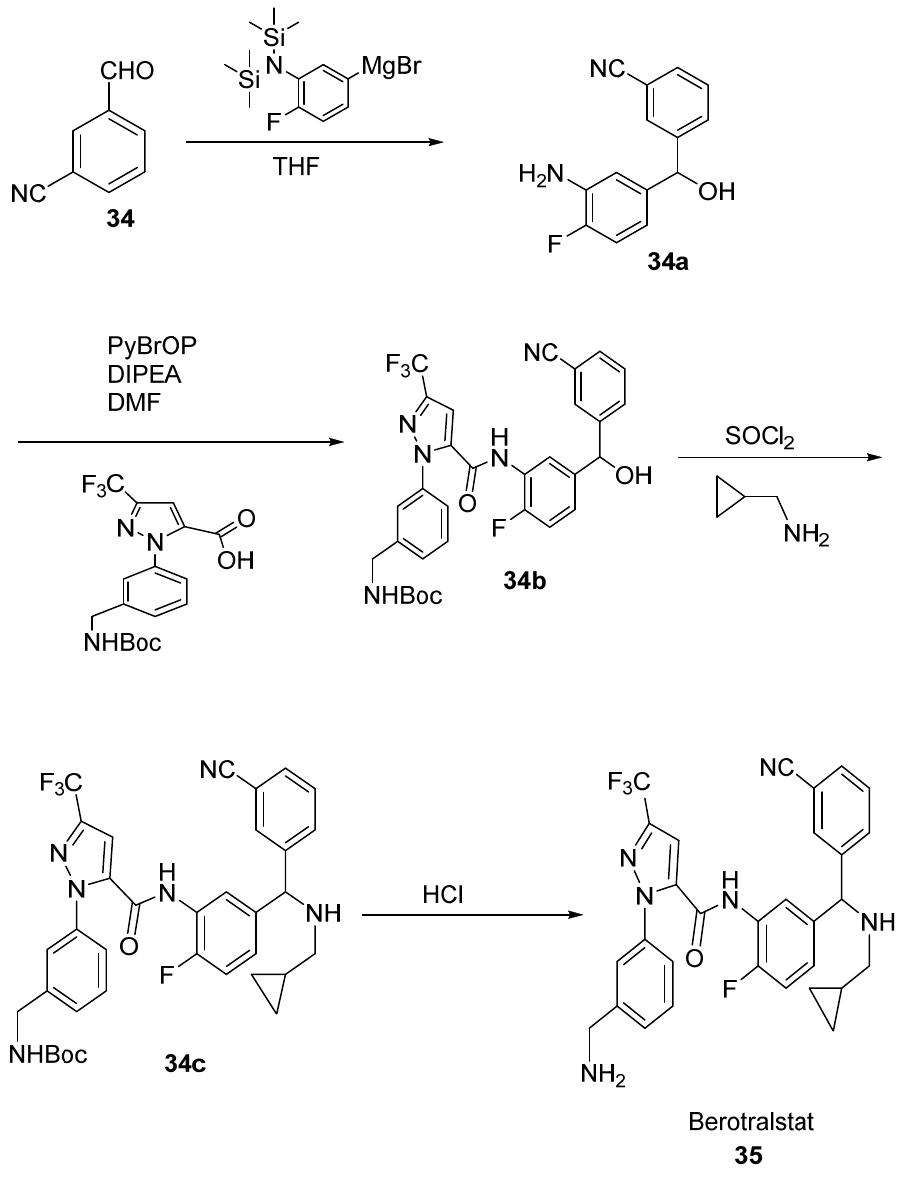
Figure 19. Synthesis and structure of berotralstat. Hereditary angioedema (HAE) attacks are the major indication for using berotralstat. Abdominal discomfort, back pain, heartburn, nausea, vomiting, bloating, excessive gas in the intestines, a sense of being full, diarrhoea, headaches, rapid or irregular heartbeats, and unusual weariness or weakness are among the adverse effects. Berotralstat’s pharma ‐ cological characteristics were observed in high absorbing quality. For 6 to 12 days follow ‐ ing the first dose, berotralstat’s balanced state was attained. After a once ‐ daily dose, bero ‐ tralstat’s concentration maxima and area under the curve were around five times higher than they were after a single dose. With the administration of berotralstat once daily by the oral route, the constant ‐ state C max at 150 mg was 158 ng/mL (range: 110 to 234 ng/mL) and 97.8 ng/mL (range: 63 to 235 ng/mL) at 110 mg. At 110 mg, the dosage interval AUC was 2770 ng.h/mL (range: 1880 to 3790 ng.h/mL) and 1600 ng.h/mL (range: 950 to 4170 ng.h/mL). In a fasting condition, the median T max is 2 h, while a high ‐ fat meal delays T max to 5 h. T max might range between 1 and 8 h. For the volume of distribution, the ratio of blood to plasma was almost 0.92, following an individual dose of 300 mg radiolabeled berotralstat administered. Berotralstat was metabolized primarily thorough CYP2D6 and